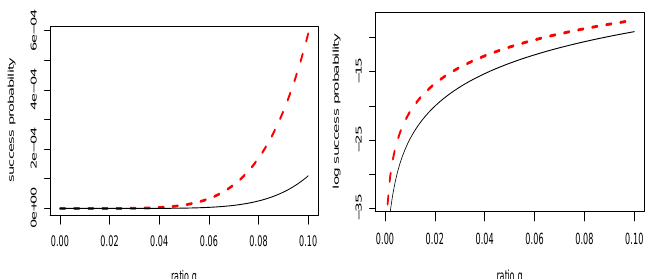
Figure 1. The success probability (and its logarithm) of the double-spending attack for n = 6 confirming blocks depending on the mining ratio q as in (4) (dashed